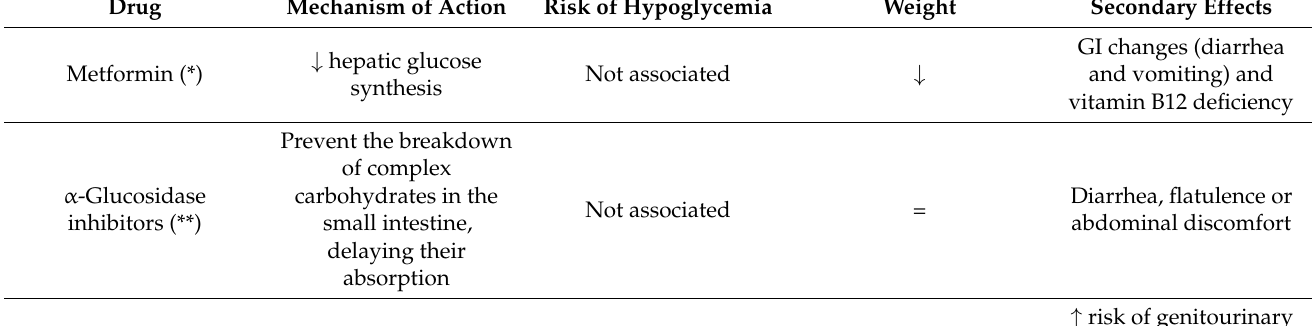
Table 2. General characteristics of anti-diabetic therapy